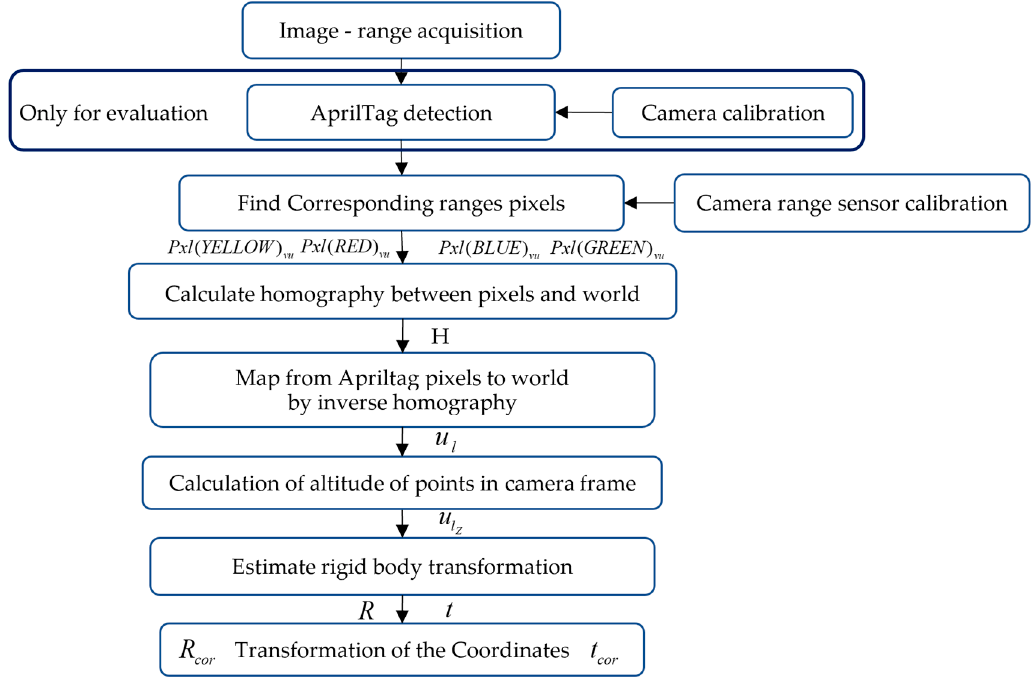
Figure 1. Overview of the IHRCF algorithm and evaluation process.